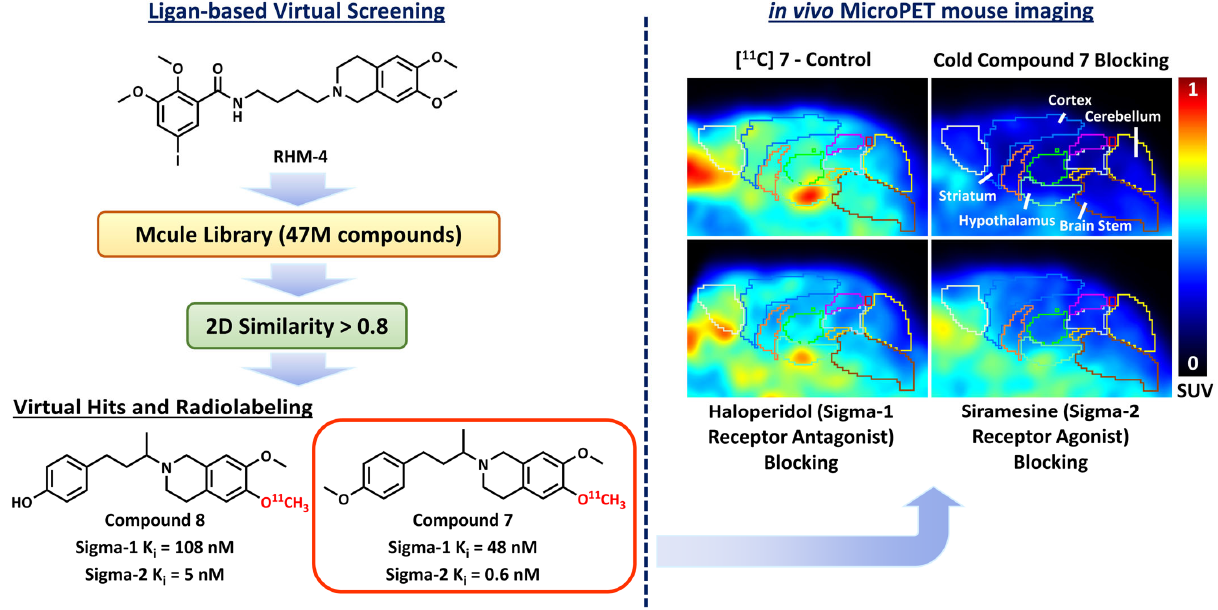
Figure 4. A summary workflow from Kim et al. that identified lead compounds from ligand ‐ based